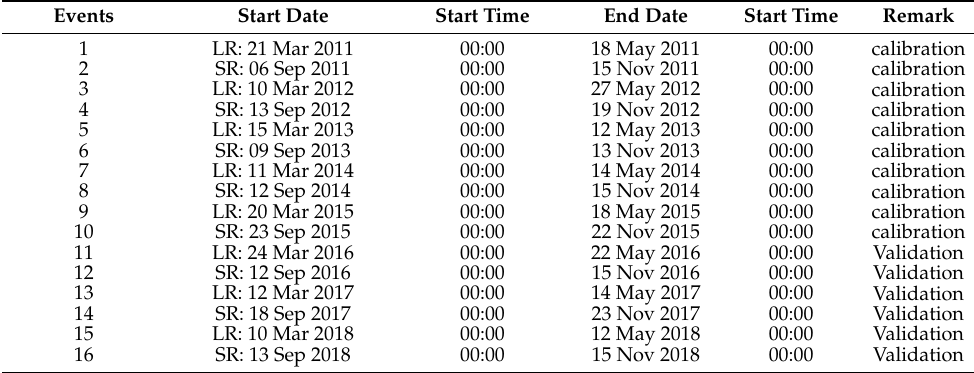
Figure 4. Methodological flow design representing the procedures for the HEC-HMS model. Table 2. Rainfall events selected for calibration and validation.